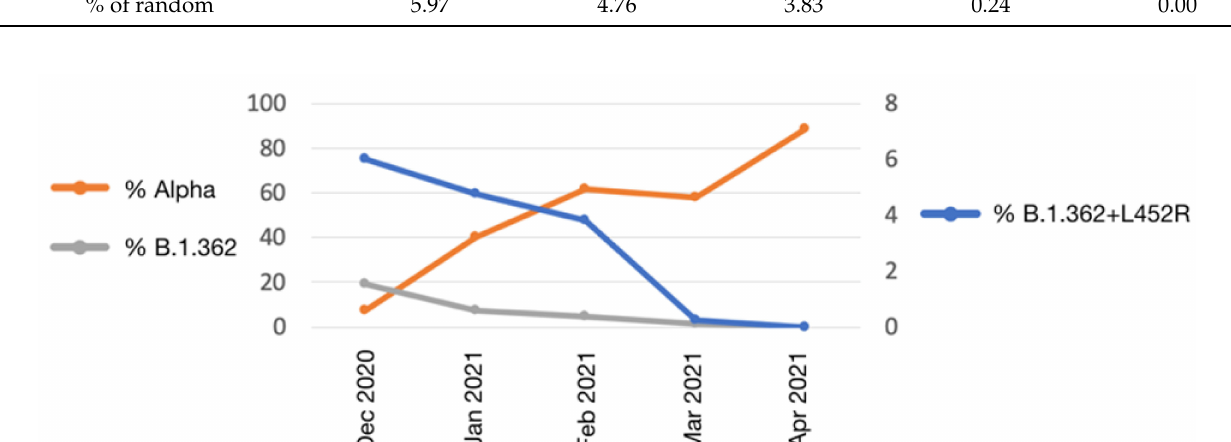
Figure 2. Prevalence of the B.1.362+L452R variant and other lineages in Israel. The prevalence of the B.1.362+L452R variant is denoted in blue (right y -axis); the Alpha variant is denoted in orange (left y -axis); the B.1.362 lineage is denoted in grey (left y